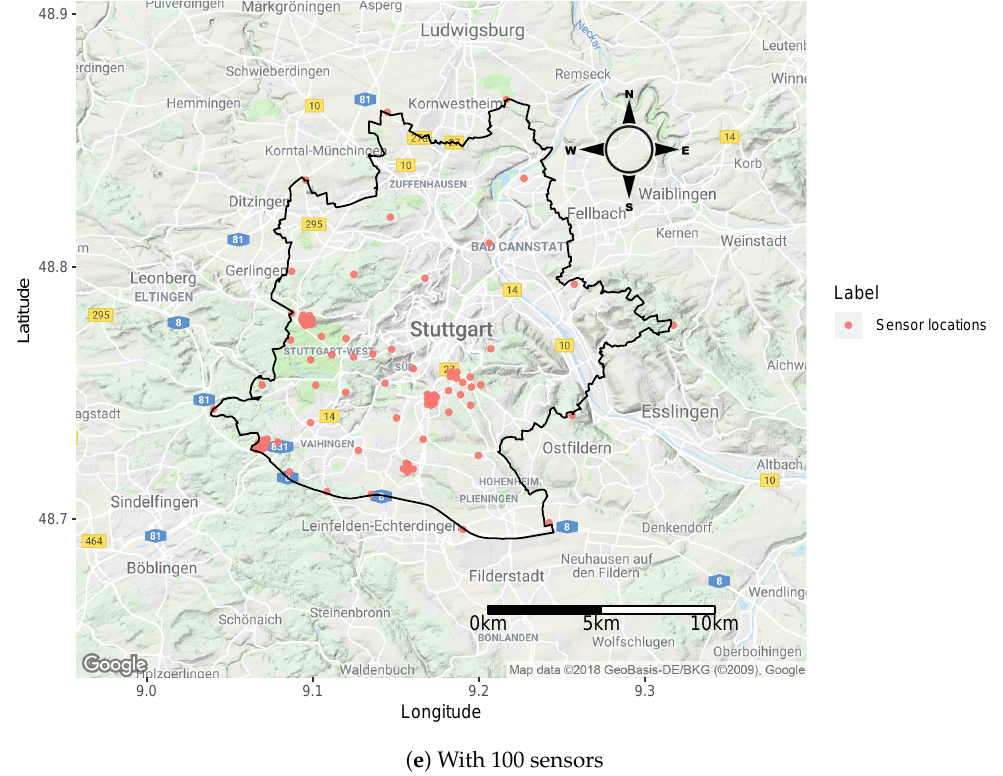
Figure 8. Optimal location identified for specific number of sensors to initiate VGI campaign.